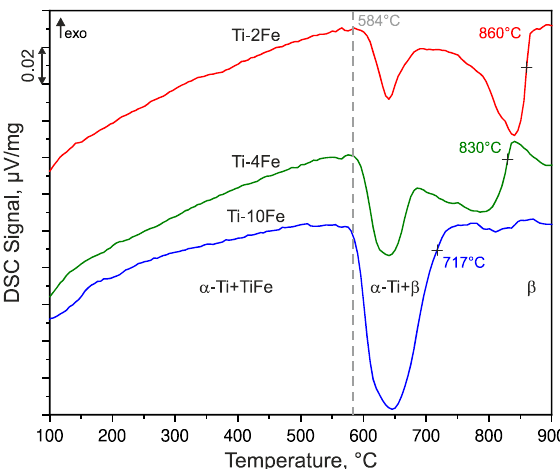
Figure 2. Differential scanning calorimetry (DSC) heating curves of alloys Ti-2Fe, Ti-4Fe, and Ti-10Fe measured with the heating rate of 10 K/min. The DSC curves were shifted vertically for better visibility. The dashed line indicates the temperature of the eutectoid reaction β ⇌ α -Ti + TiFe. The crosses indicate the β -transus temperatures (solvus temperatures of the β phase), which were determined as inflection points of the respective DSC curve.